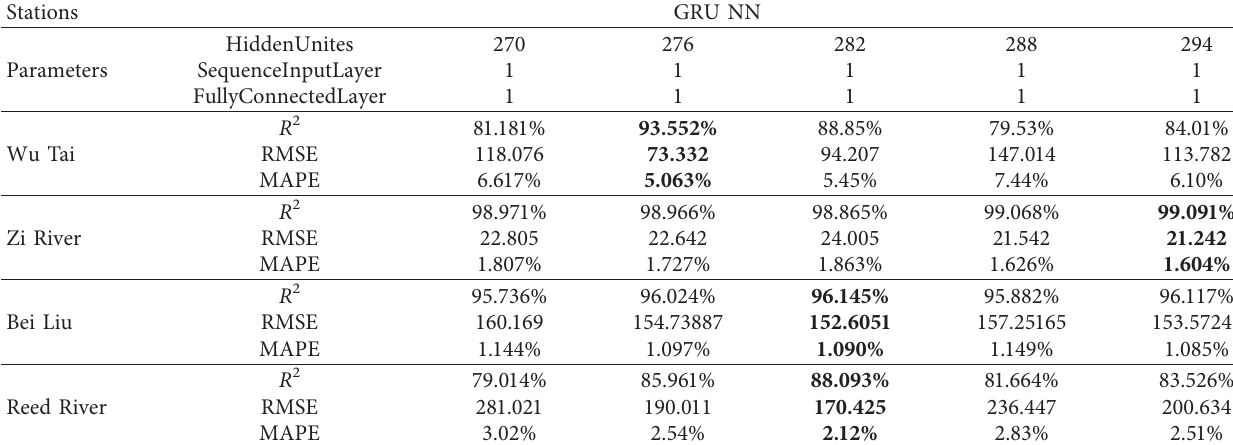
Table 5: Traffic flow prediction accuracy evaluation of GRU